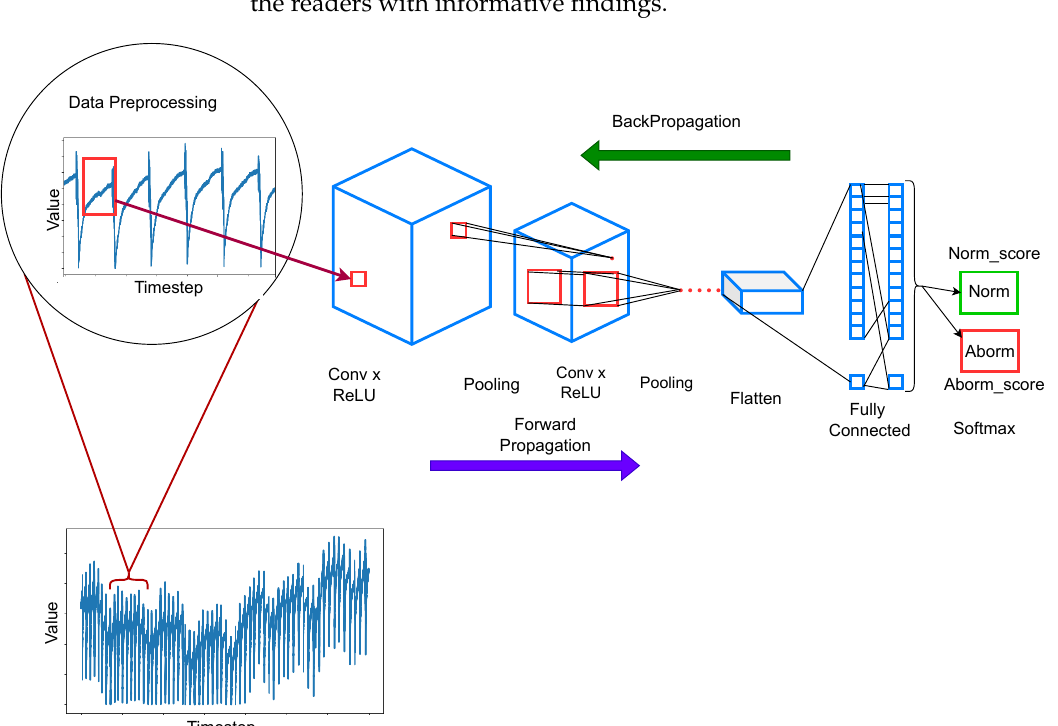
Figure 1. The illustration of steps followed from data to input to the final classification of each given data sequence converted to raw pixel images and fed to the end-to-end anomaly detection system built using a 2D-Convolutional Neural Network architecture that outputs the class of the given input